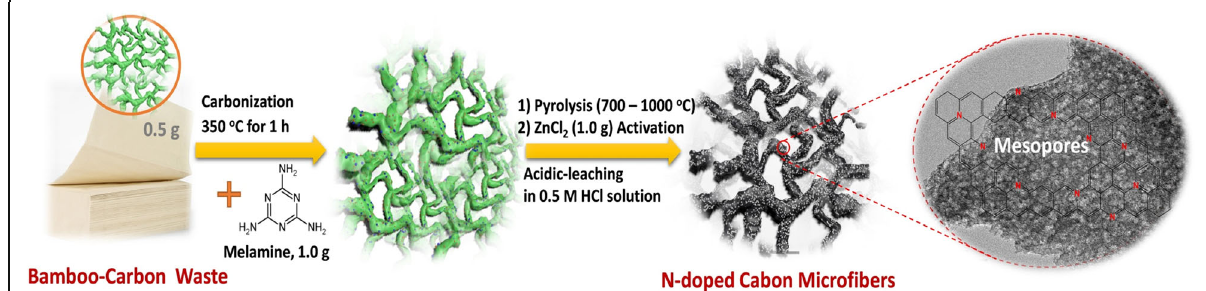
Fig. 1 The schematic illustration for synthesis of mesoporous nitrogen-doped carbon microfibers for ORR electrocatalysis via the activation-assisted carbonization of bamboo-carbon